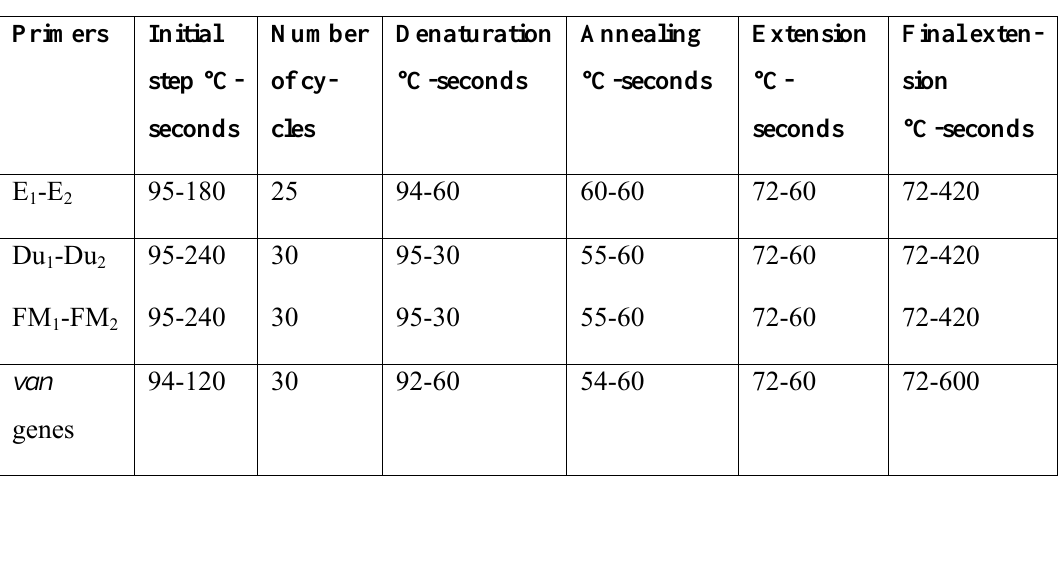
Table 8. The used thermal profile used for PCR